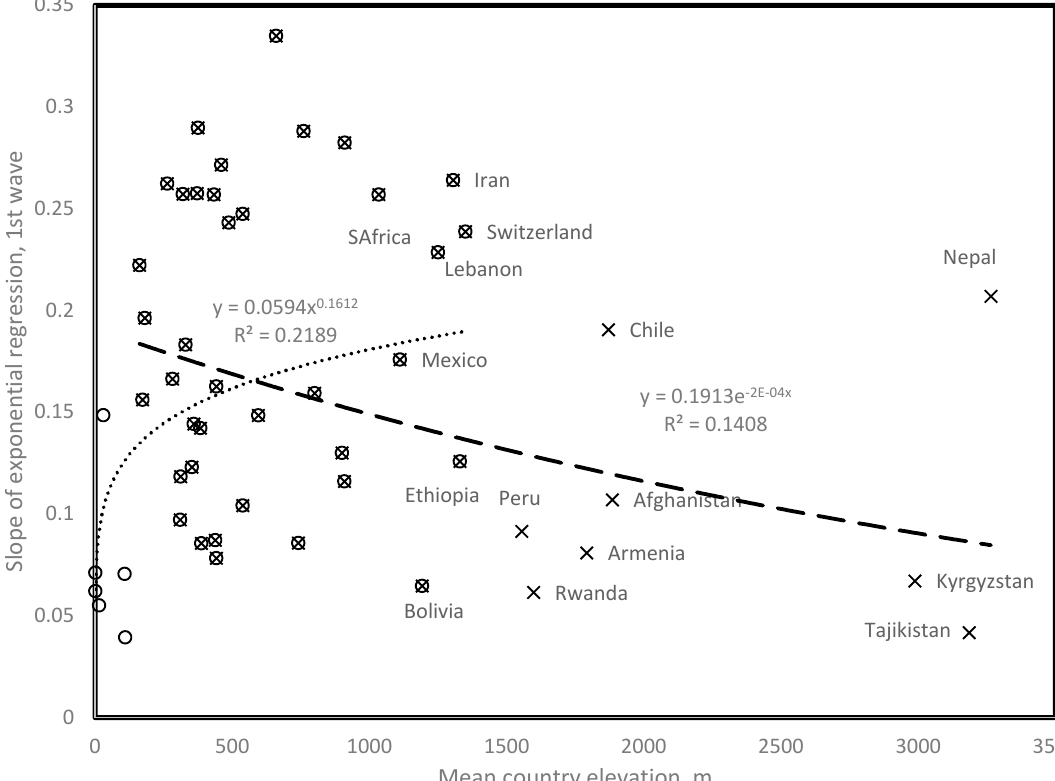
Figure 1. Slope of daily new confirmed Covid-19 cases as a function of mean country elevation. (Circles) Countries contributing to the positive trend with elevation, up to 1400 m, r = 0.468, two tailed p = 0.0018; (X) Countries contributing to the negative trend with elevation, down to 110 m, r = − 0.375, two tailed p = 0.01. Note that for countries above 1000 m, landlocked or isolated countries tend to fit the negative trend (for example, Bolivia, Ethiopia, Armenia, and Afghanistan) as opposed to countries with large coastal populations (for example, Chile and South Africa) and landlocked Nepal and Switzerland probably contaminated by tourists from low elevation countries. Peru has a low slope and a large coastal population. Data are from Table